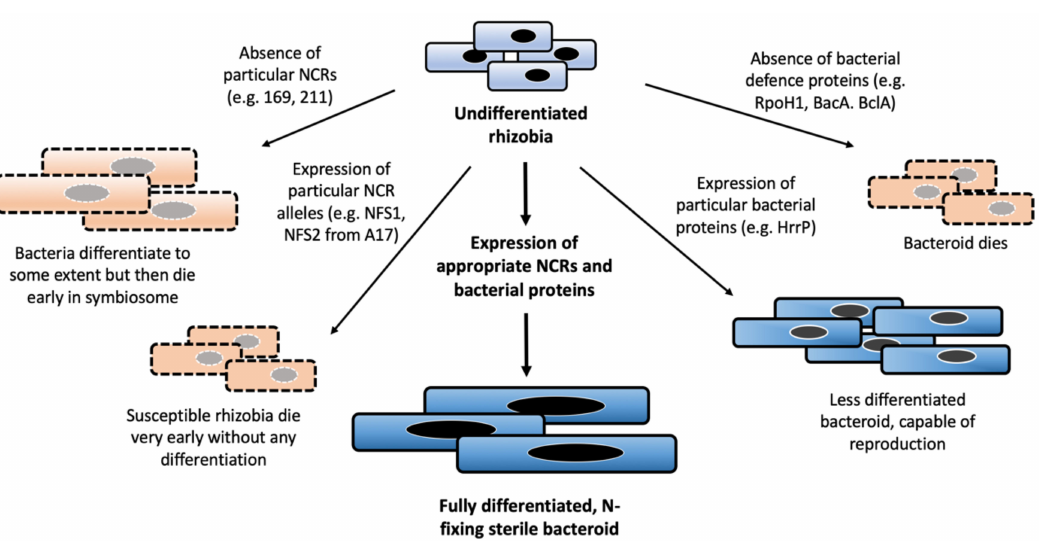
Figure 4. Expression of particular plant NCRs and bacterial proteins alters the fate of rhizobial bacteroids in the nodule. Research has identified the importance of NCRs not only that have defensin-like roles to kill rhizobia (e.g., NFS1 and NFS2 in M. truncatula A17) but that are required for bacterial